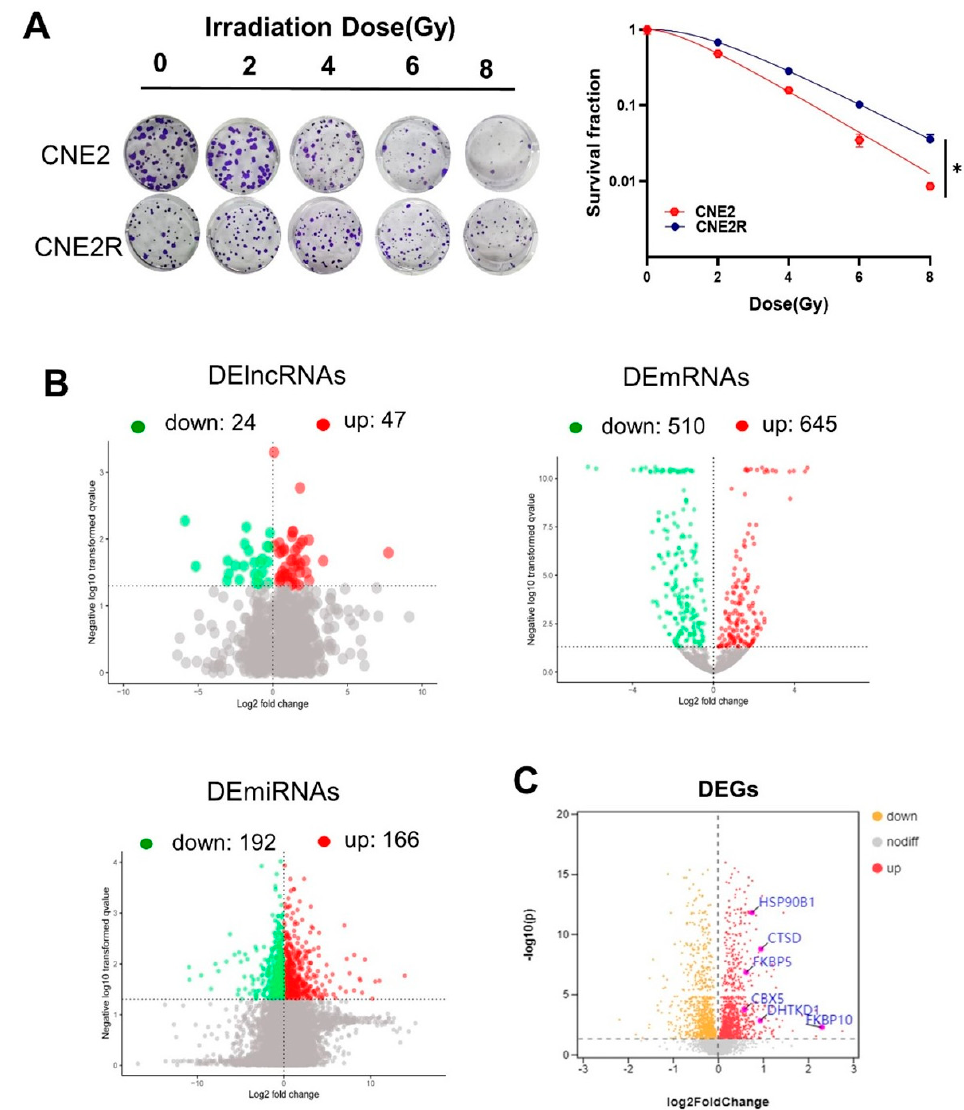
Figure 1. RNA profile analyses of CNE2 and its paired radioresistance CNE2R cells: ( A ) colony formation assay was performed to evaluate the radiosensitivity of CNE2 and CNE2R cells. * p < 0.05 between indicated groups; ( B ) volcano plots of the DElncRNAs, DEmRNAs, and DEmiRNAs between CNE2 and CNE2R cells based on RNA − seq assay; ( C ) volcano plot of differentially expressed genes (DEGs) between CNE2 and CNE2R cells based on TMT assay.